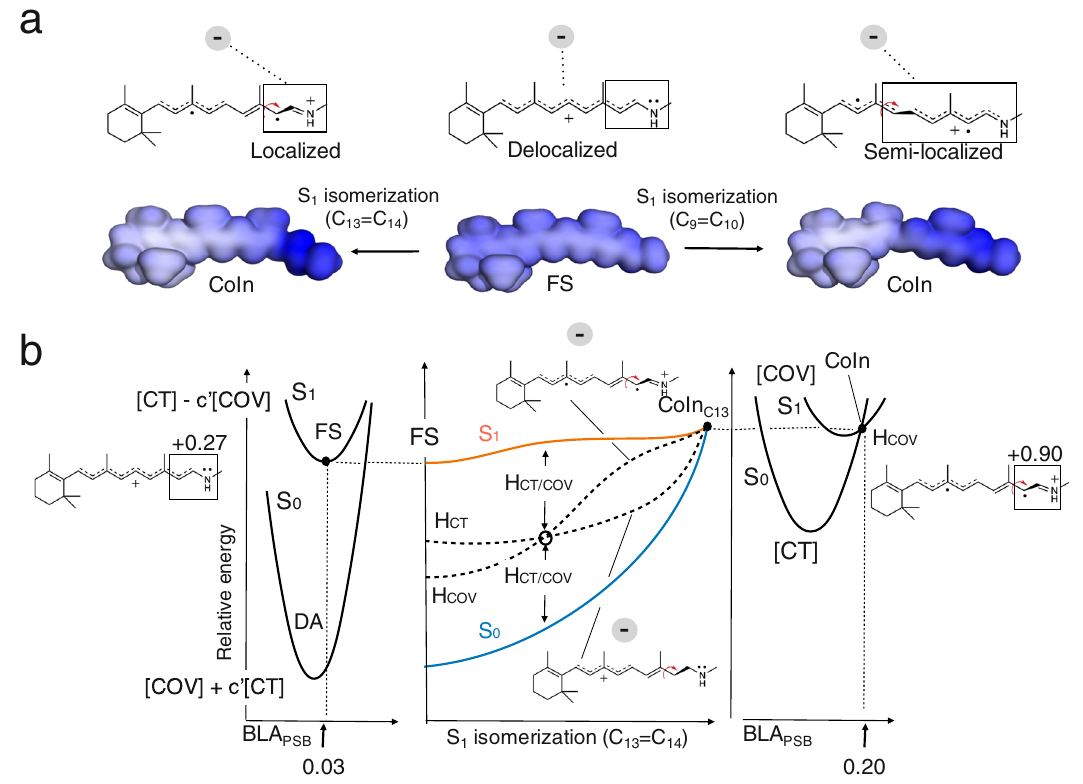
Fig. 5 | Origin of the E f S1 barrier in NeoR. a Representation of the increase in the distance between the negative and positive charge centroids due to the positive charge con fi nement along the C13=C14 and C9=C10 photoisomerization paths. Comparison between electrostatic potential (ESP) maps indicates that along the C9=C10 coordinate the extent of the con fi nement is less pronounced being the chargeattheCoInspreadonalongerrPSBchromophoremoiety(i.e.,C10-C11-C12- C13-C14-C15-N). b Proposed origin of the isomerization barrier in terms of COV energy( H COV ,dashed line)destabilizationdueto thecharge con fi nementresulting from the mixed[CT]- c ’ [COV] tothe pure[COV]electronic structurechange along